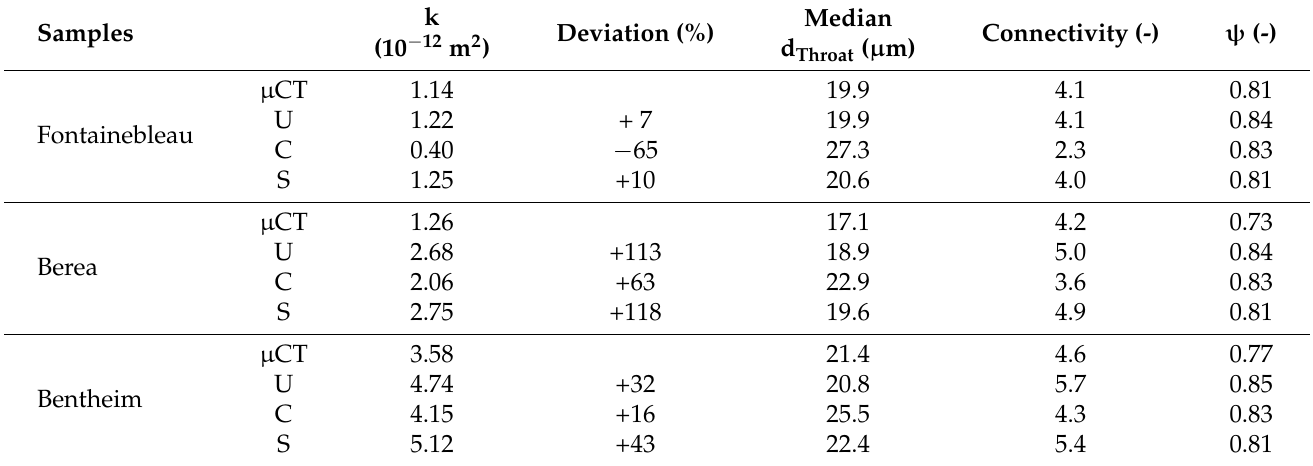
Table 4. Hydraulic and related geometric properties of the micro-CT scans ( µ CT) and synthetic sandstone samples cemented by the three different schemes (U, C,